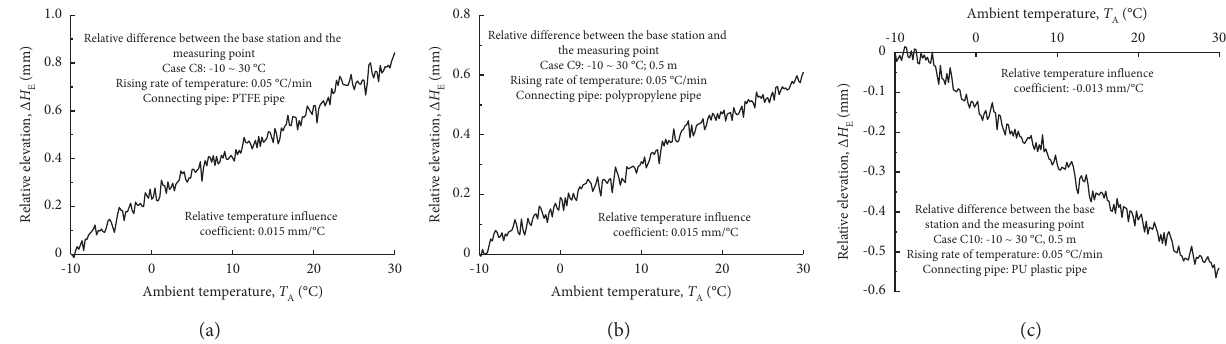
Figure 8: The relative elevation between the base station and test point HLS versus ambient temperature for cases C8–C10. (a) PTFE pipe. (b) Polypropylene 204 pipe. (c) PU plastic pipe.